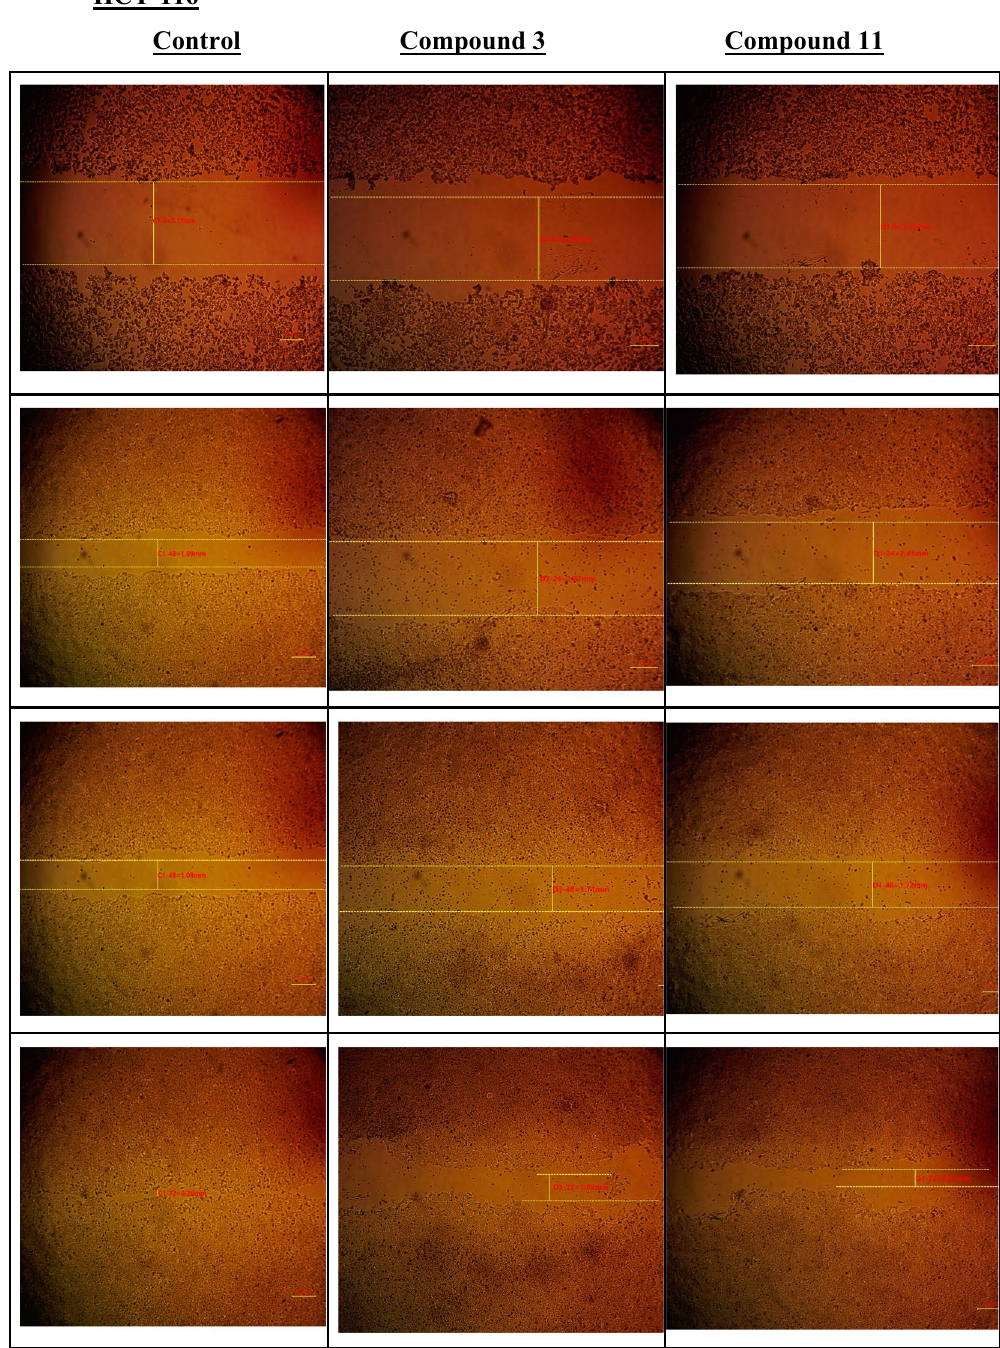
Figure 9. Wound closure percentage for both compounds 3 and 11 after three-time intervals, 24, 48, and 72 h on HCT-116